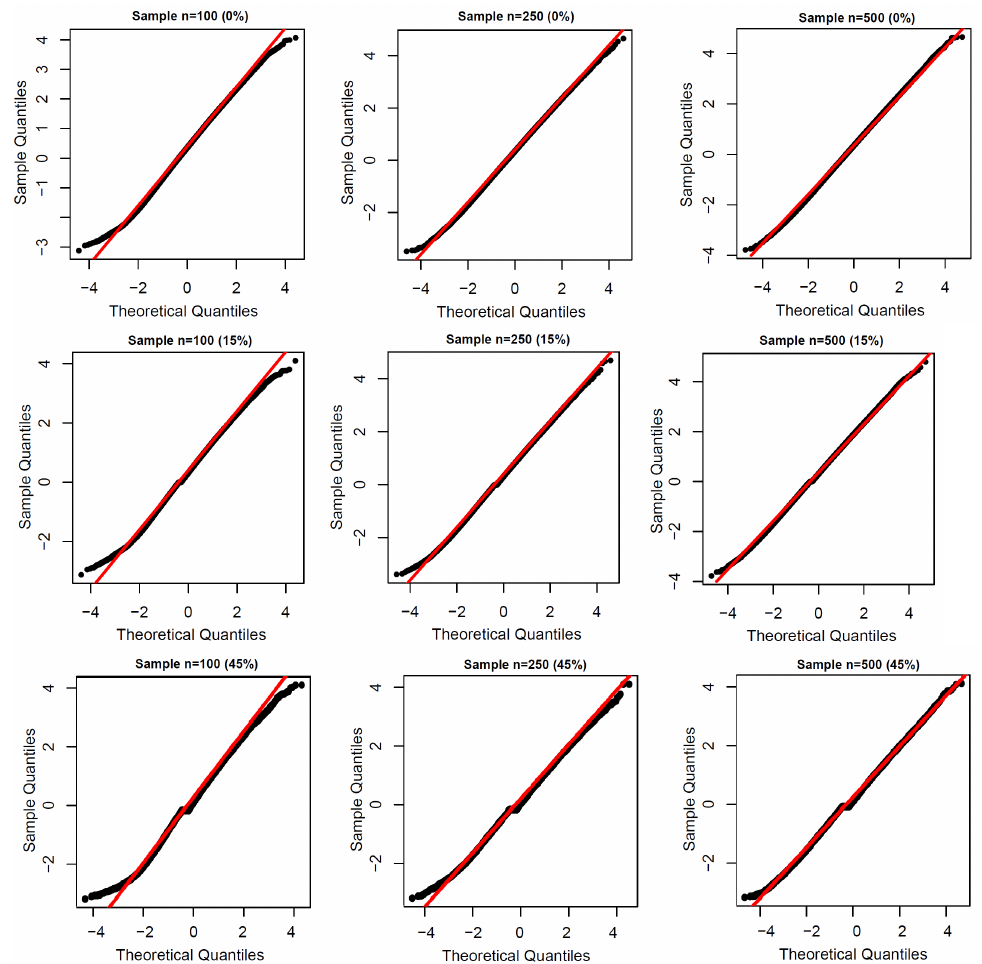
Figure 2. Normal probability plots of r D 10%, and